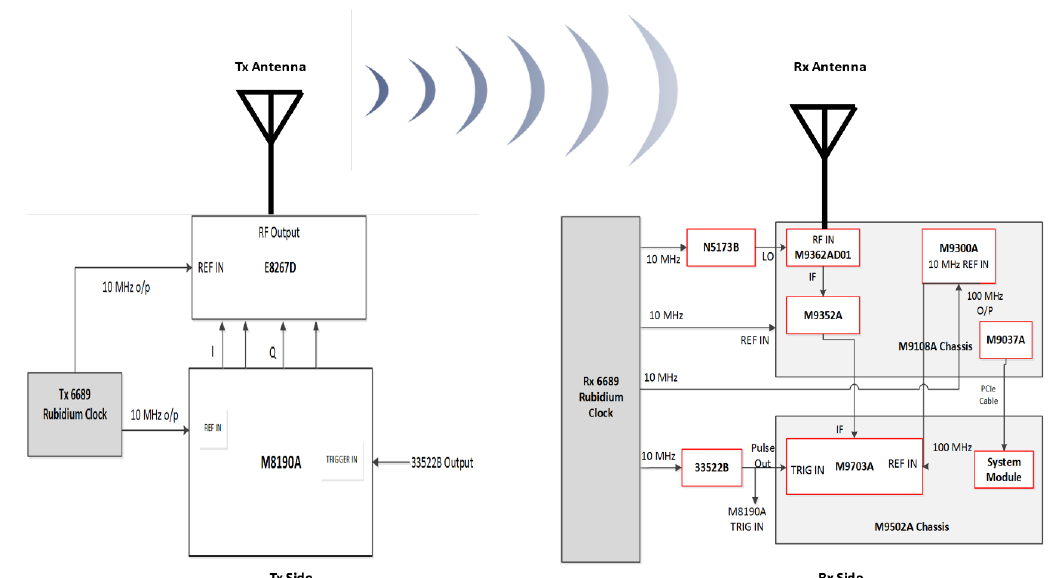
Figure 1. Block diagram of transmitter (Tx) and receptor (Rx) components for a 5G channel sounder.